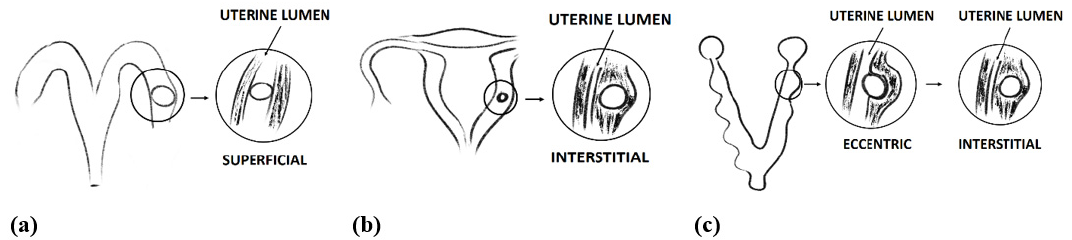
Figure 1. Models of implantation: ( a ) superficial in rabbit, ( b ) interstitial in human, and ( c ) eccentric and interstitial in rodents.